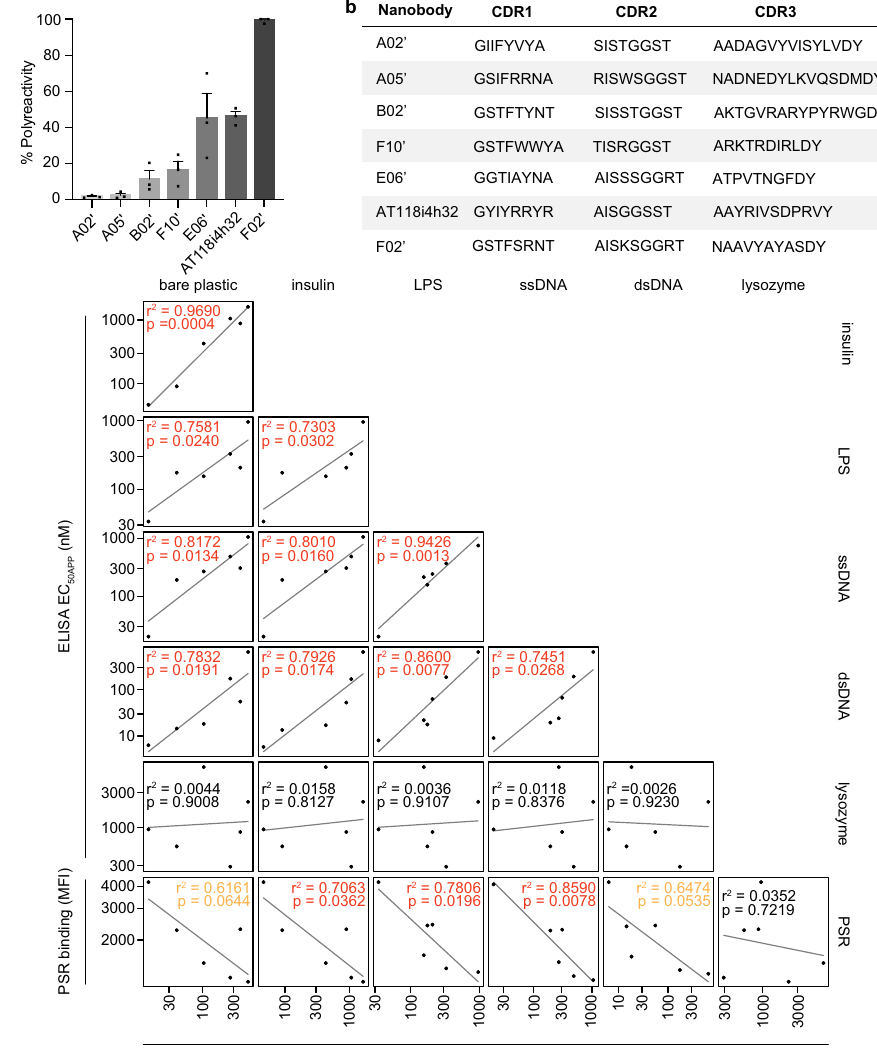
isolatednanobodies. c DirectELISAassaysmeasuredtheapparentEC 50 (EC 50APP )of fi ve index set members and nanobody AT118i4h32 to the speci fi ed reagents. Non- speci fi c binding, indicated bylow EC 50APP values, correlates with strong binding to PSR. ELISA data are representative of two independent experiments, each per- formed in technical